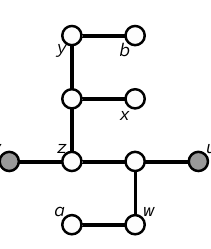
Fig. 11: Diagram showing T 2 . c ( u ) = c ( v ) is an available color for x, a, b .